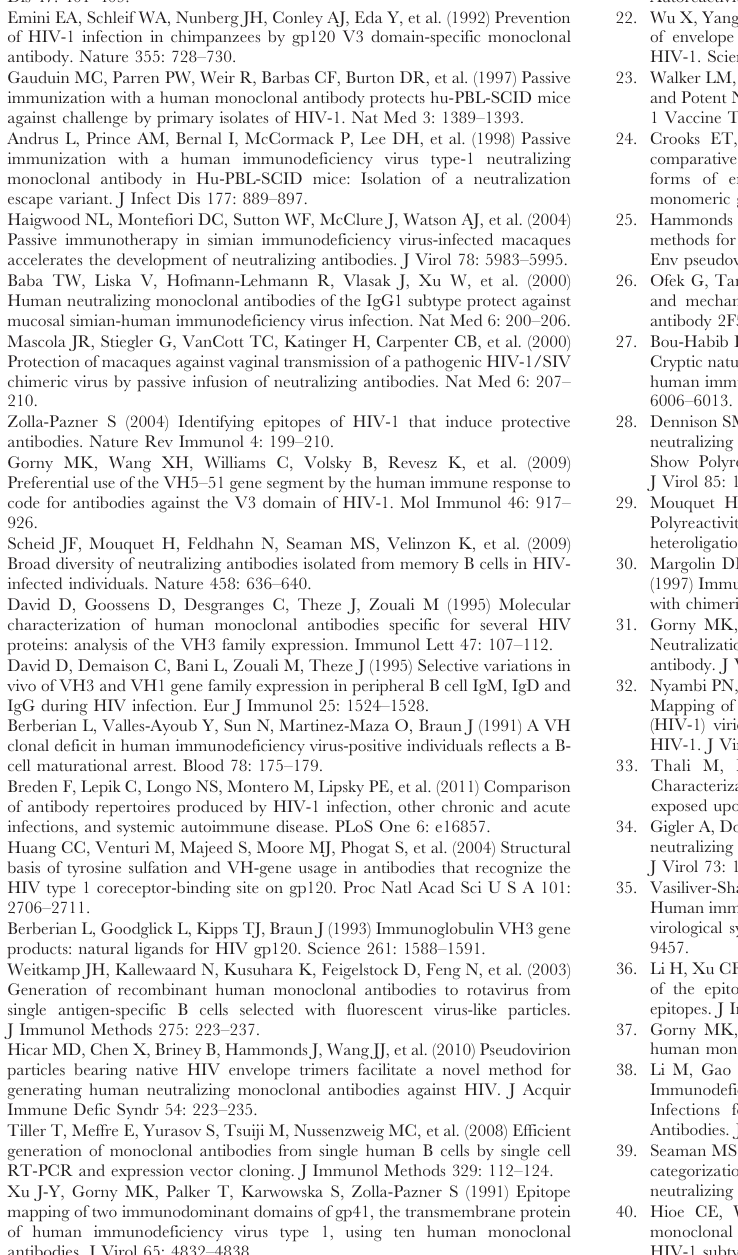
Table S2 Human non-HIV-1 mAbs produced from single IgG + B cells selected using BaL-VLPs. The listed 19 mAbs were produced from B cells selected with VLPs expressing HIV-1 BaL Env proteins and did not show any binding activity to Env proteins. Table S3 Human non-HIV-1 mAbs selected from single IgG + B cells using Gag-VLPs. This table shows a list of 15 mAbs, selected by VLPs without HIV-1 Env proteins, which did not react with Env